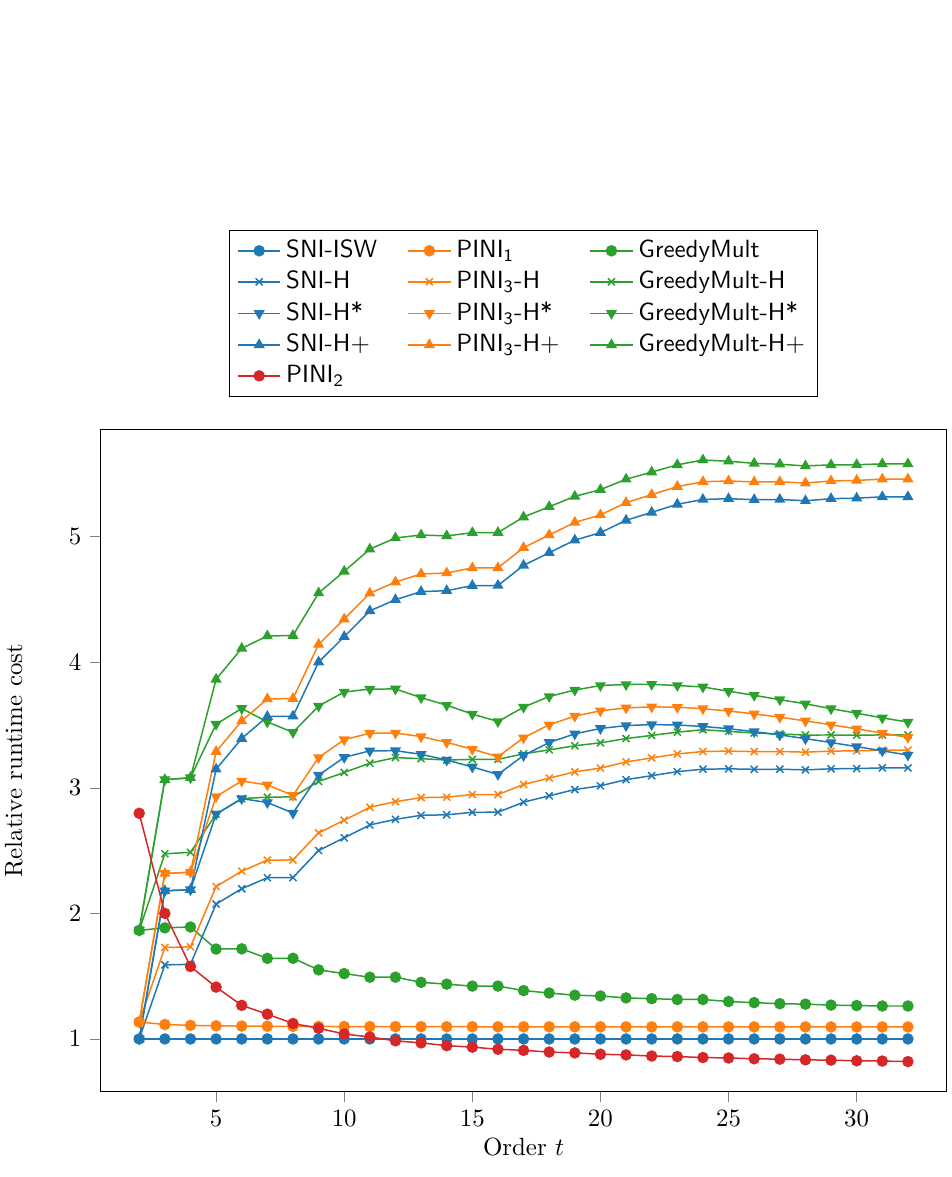
Figure 11: Runtime cost (relative to the SNI-ISW multiplication gadget) of different masked multiplication gadgets (with different noise